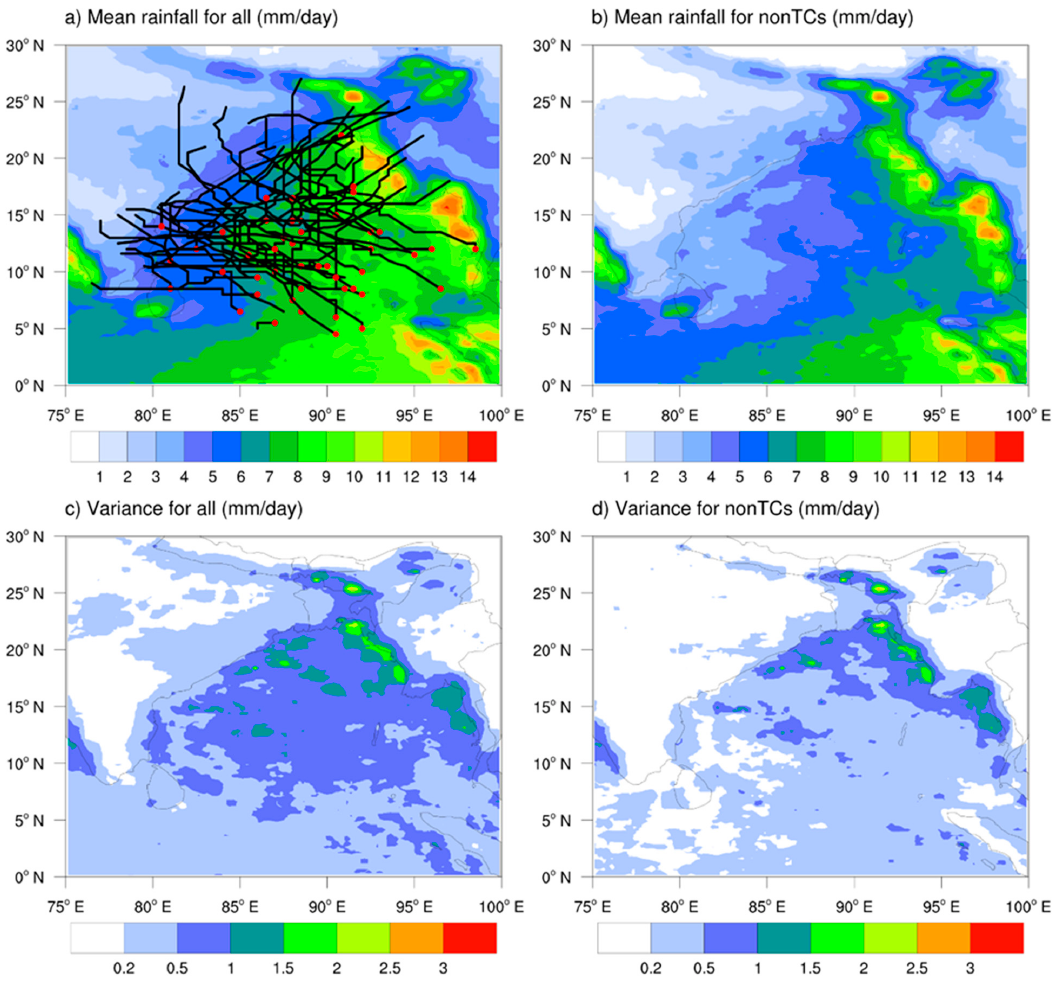
Figure 3. Yearly mean precipitation in BoB during 1998–2016 ( a ) for all events (TCs and non-TCs), ( b ) for non-TC, and precipitation variance ( c ) for all, ( d ) for non-TCs. The red dots in ( a ) indicate TC genesis points.